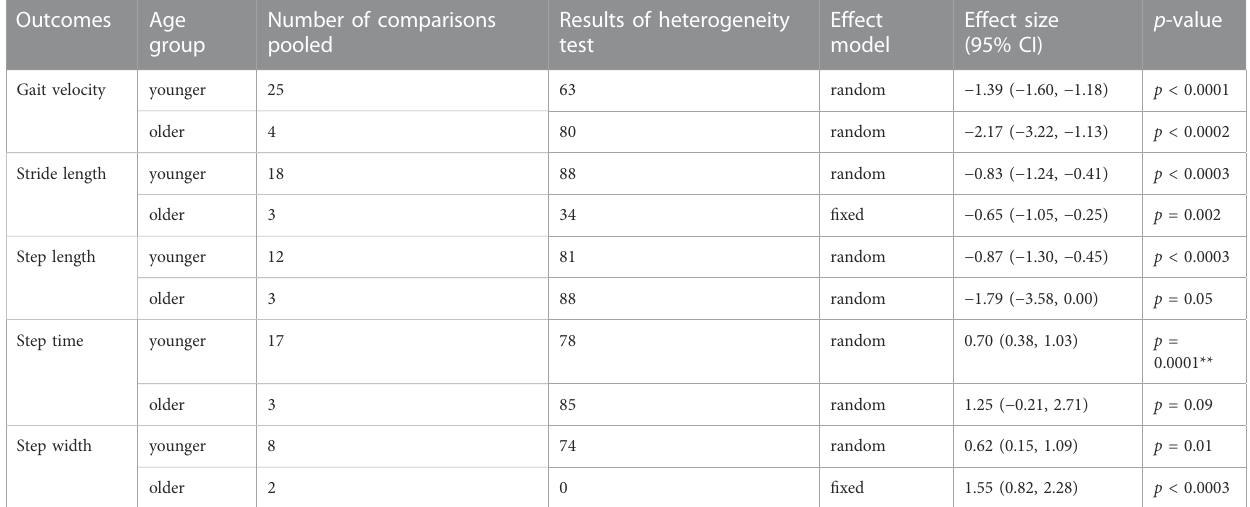
TABLE 4 Subgroup analysis of the effect of mobile phone use on gait parameters in participants of different ages.